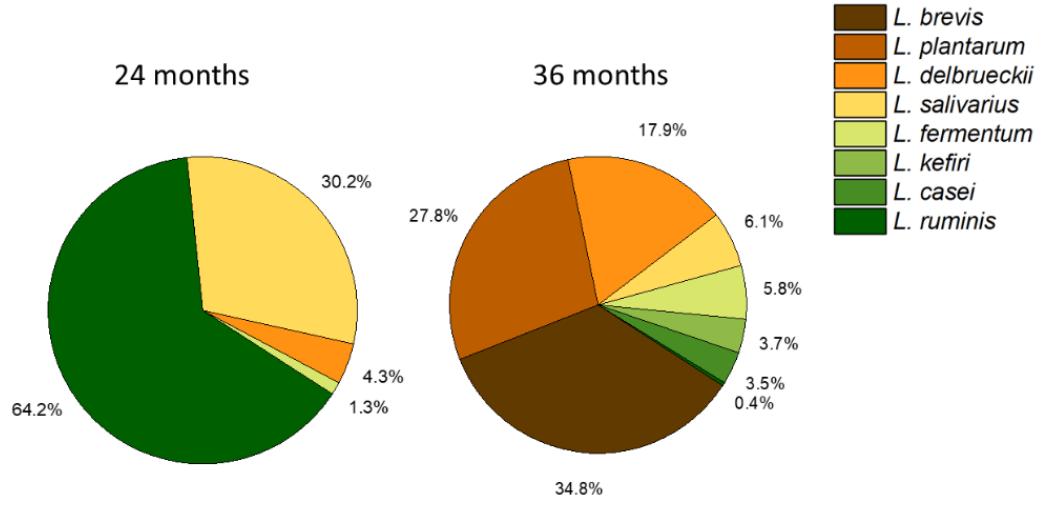
Figure 3. The average relative abundance of Lactobacillus sequences from children of Kabale and Kisoro, southwestern Uganda, at the age of 20–24 months and at 36 months. Lactobacillus species with a relative abundance of ≤ 0.01% were not included. The following combinations of species could not be unambiguously resolved as their 16S rRNA V4 amplicon sequence showed identical matches to the sequence in the 16S rRNA database: L. delbrueckii and L. leichmannii, L. plantarum and L. pentosus, and L. casei and L. paracasei